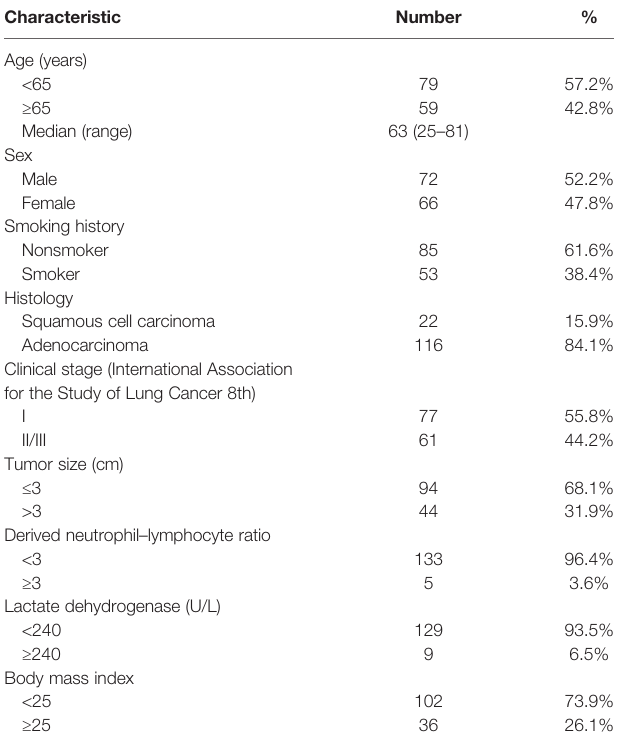
TABLE 1 | Clinicodemographic characteristics of the study patients.